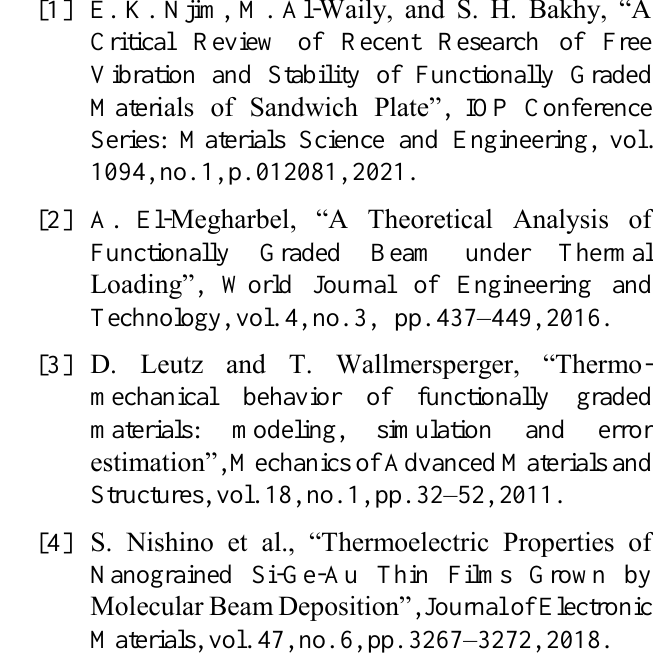
Fig. 24. Graph of total information (0.10743 mm) at the thermal condition for the whole body 500 °C and normal force 250 N